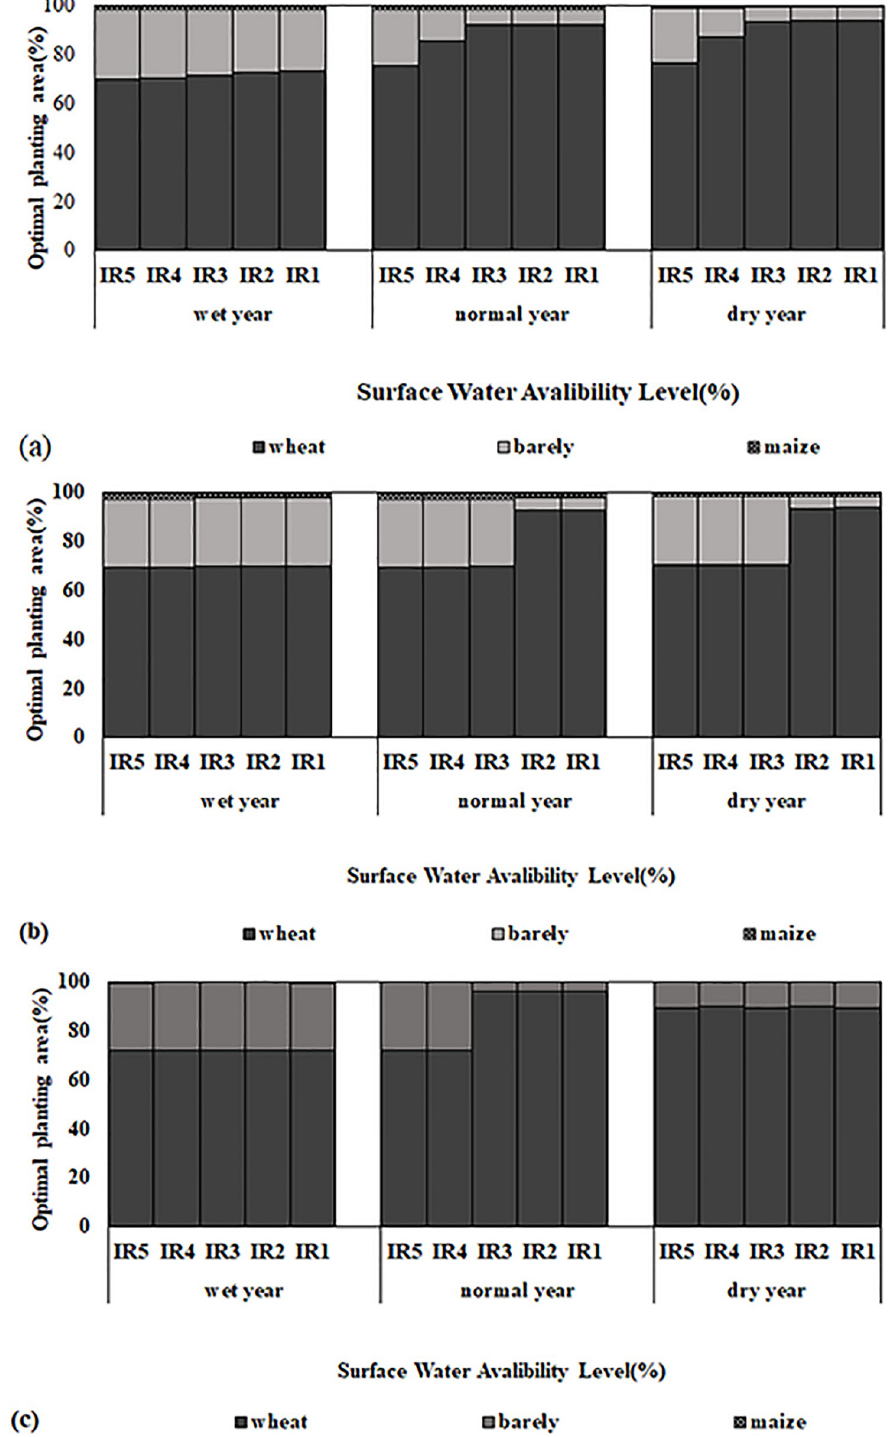
Fig 6. Optimal area water for each crop and optimal applied irrigation with different water allocations level (from full irrigation to 40% deficit irrigation) under the different climatic scenarios:(Present: Cultivated area and irrigation demand in present situation), a: Soil type1 (EC < 4), b: Soil type2 (4 < EC < 8), c: Soil type3 (EC > 8 ds/m).